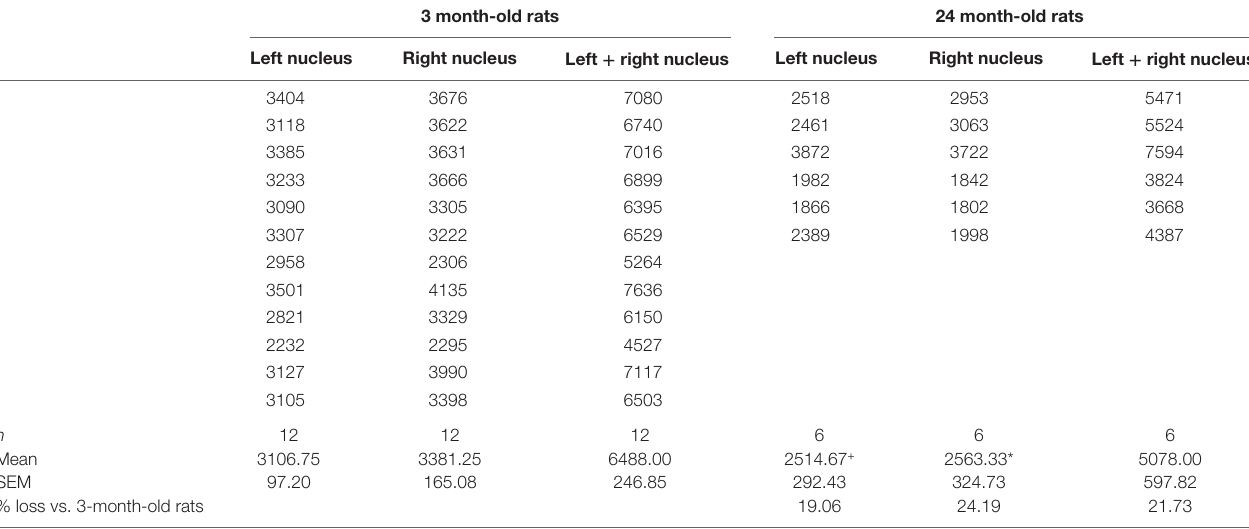
TaBle 2 | numbers of motor neurons in the left and right facial nuclei of 3- and 24-month-old rats. 3 month-old rats 24 month-old rats left nucleus right nucleus left + right nucleus left nucleus right nucleus left + right